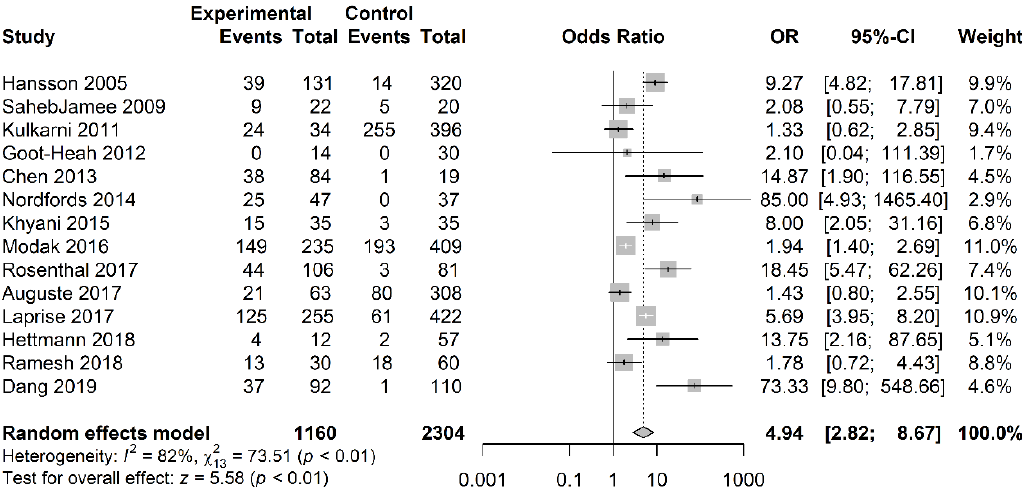
Figure 3. Forest plot for the studies on the association between salivary HPV and oral and oropharyngeal cancer. The squares indicate the ORs (odds ratios) in each study, with square sizes inversely proportional to the standard error of the OR. The diamond shape indicates the pooled ORs. Horizontal lines represent 95% CIs (confidence intervals), I2 > 50% indicates severe heterogeneity.